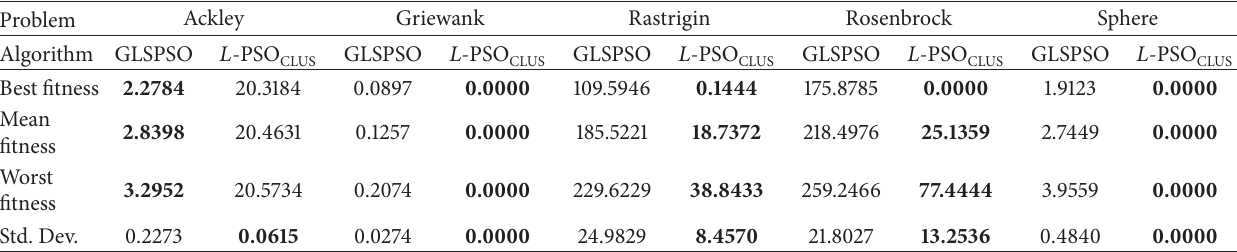
for problems with dimension of CLUS